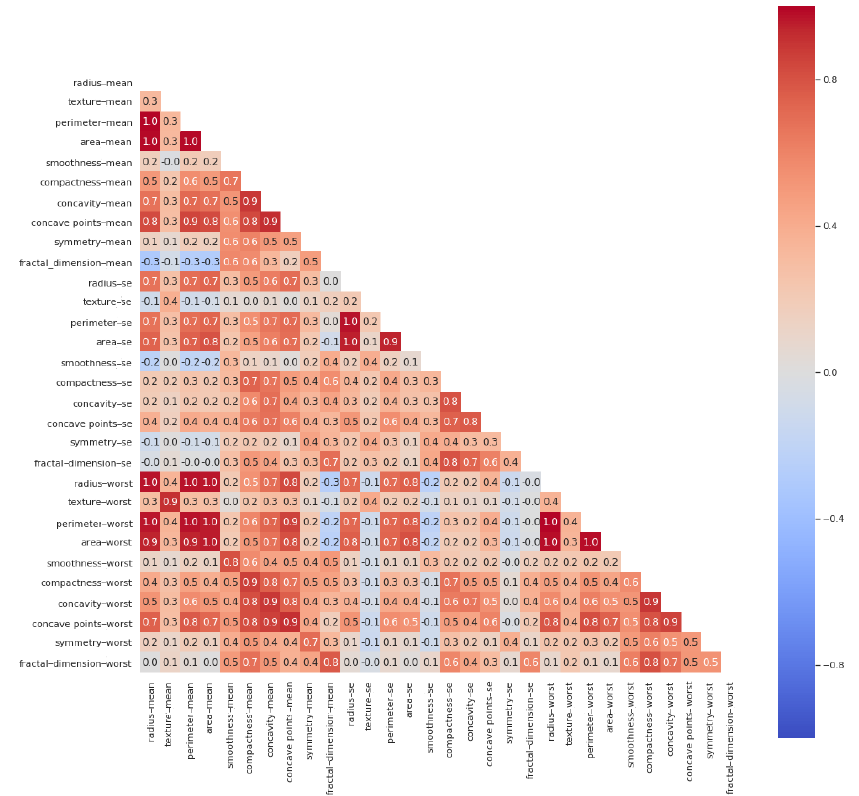
Figure 2. Heat map plot showing the correlations among input features of WBCD dataset. High correlations were observed between the features representing the “mean” and “worst” values of different features. For instance, the “radius-mean” feature is highly correlated with the “radius-worst” feature. The feature representing the “worst” value of “radius” was dropped, as it is just a subset of the “mean” value feature. Similarly, high correlations were observed between the features containing information about the shape of breast cancer cell—i.e., compactness, concavity, and concave points. For better breast cancer cell shape representation, we decided to only consider the “compactness-mean” feature for further processing. We dropped a total of nine features: “area-mean, perimeter-mean, radius-worst, area-worst, perimeter-worst, texture-worst, concavity-mean, perimeter-se, area-se.” This way, we had 22 features remaining for further processing. Figure 3 shows the correlations among the selected